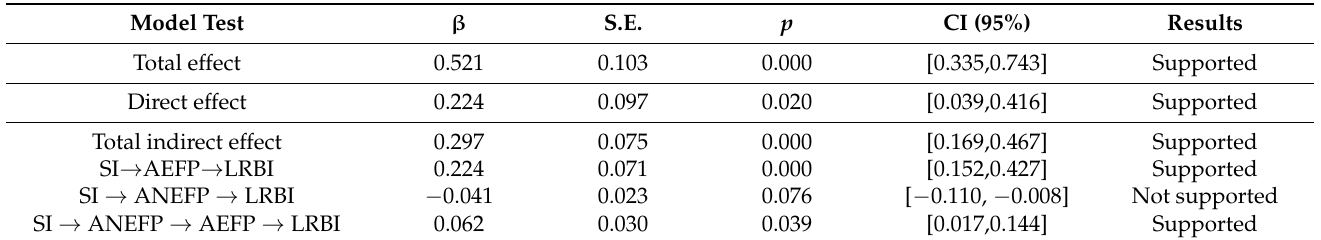
Table 6. Mediation effect test